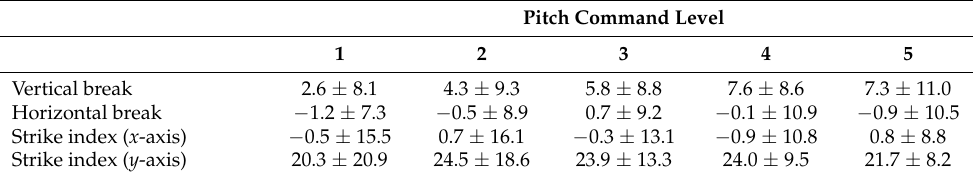
Table 4. Description (mean ± SD) of pitch performance measures of pitch movement (vertical and hori-zontal break) and location (x-y strike index coordinates) across levels of pitch command. Pitch Command